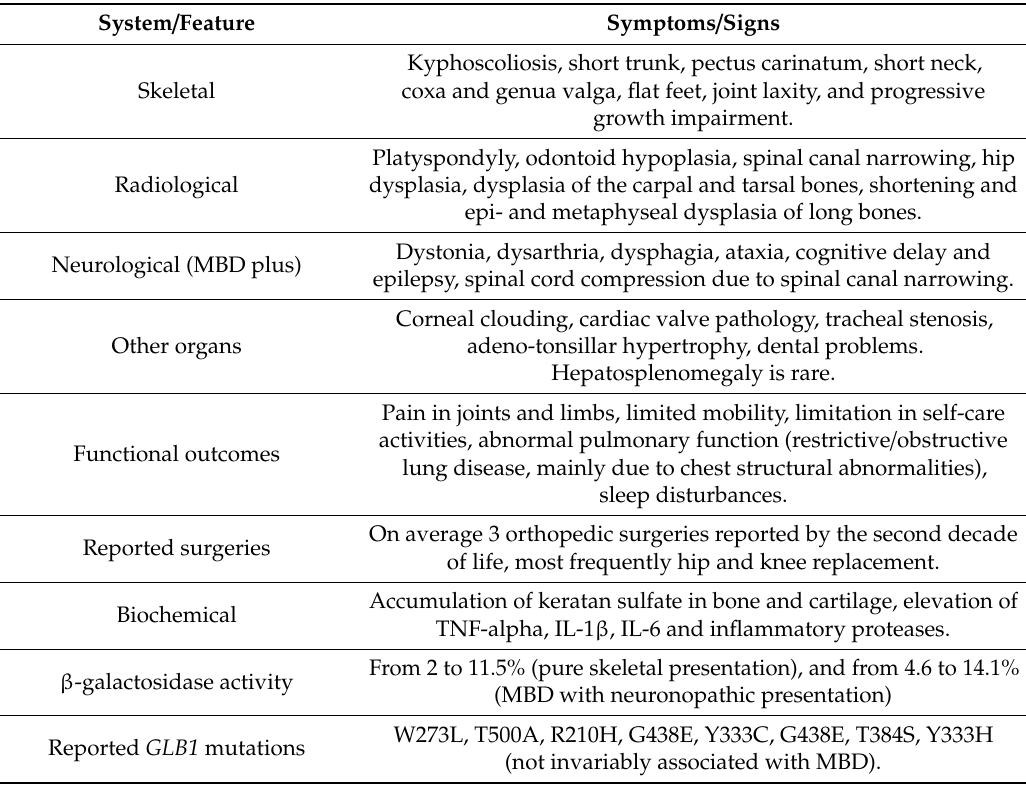
Table 1. Summary of the clinical, biochemical, and genetic features of Morquio B